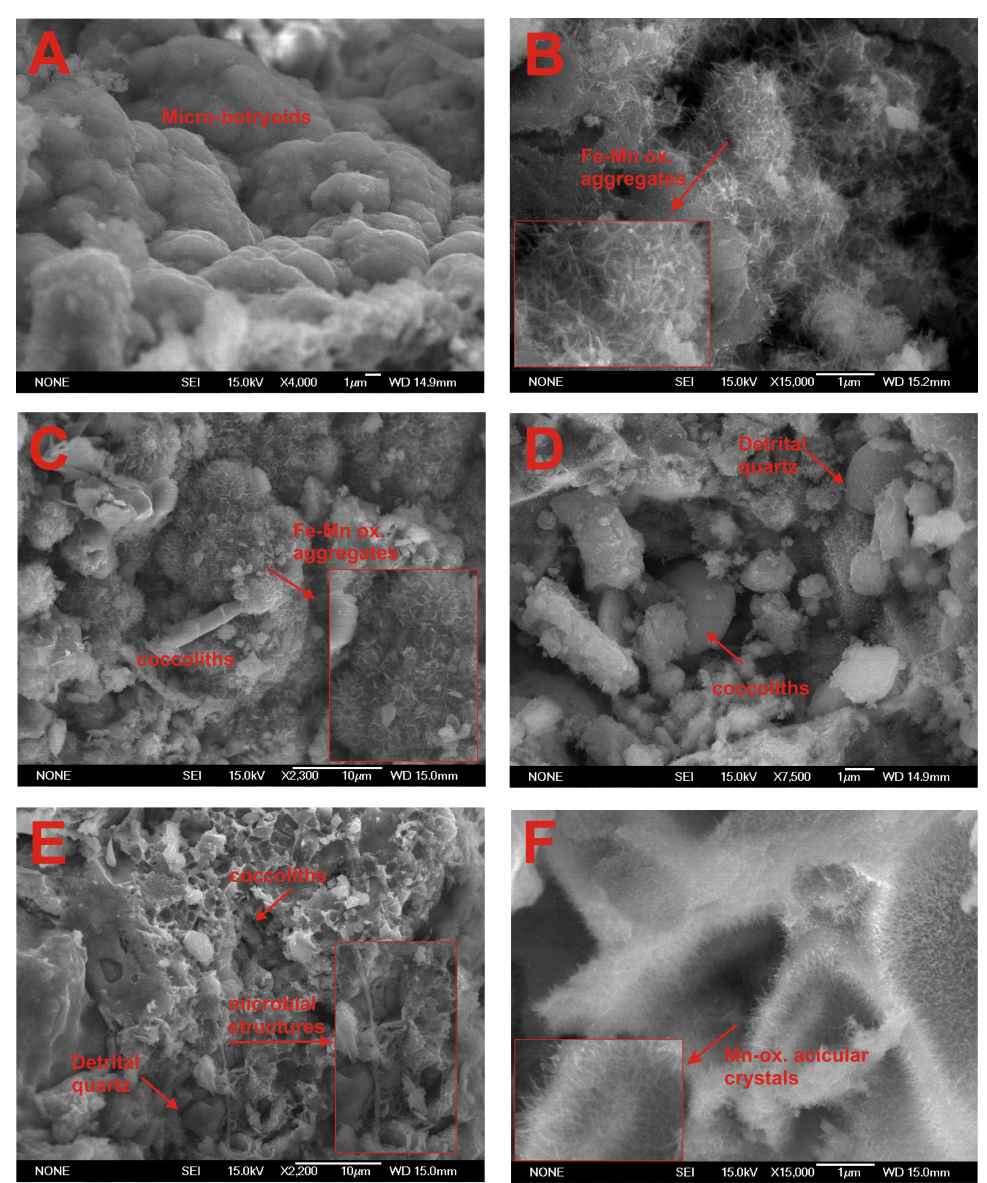
Figure 6. SEM photomicrography. ( A ) Micro-botryoidal morphology ( B , C ) Acicular micro aggregates of Fe–Mn minerals forming rounded shapes and sometimes covering other minerals or bio-clasts ( F ). ( C , D ) Detrital grains, coccoliths and ( E ) Biological tubular structure identified crossing through the Fe–Mn